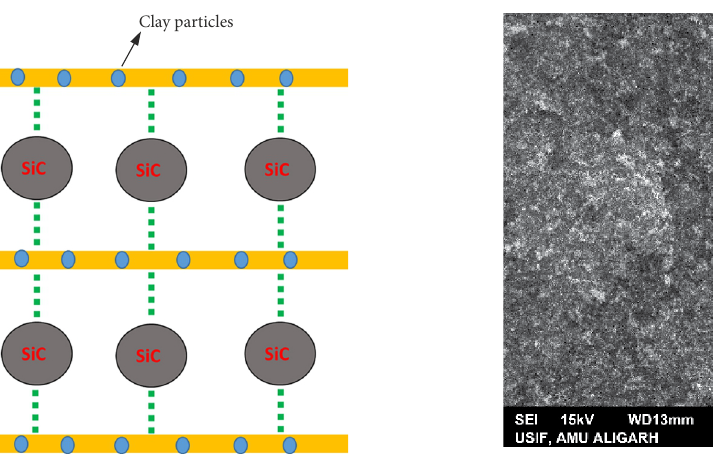
Figure 5. SEM image of SiC nanoparticles